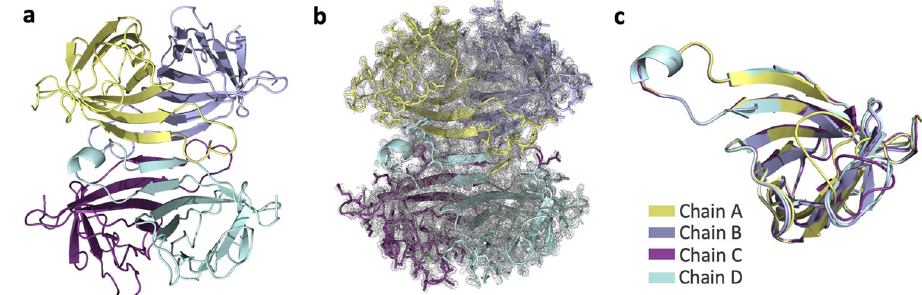
Fig. 1 Apo-SFX structure of streptavidin. a The Apo structure of streptavidin is colored based on each chain. b 2 F o- F c simulated annealing-omit map at 1 sigma level is colored in gray. c Each chain of streptavidin is superposed with an overall RMSD of 0.177 Å.